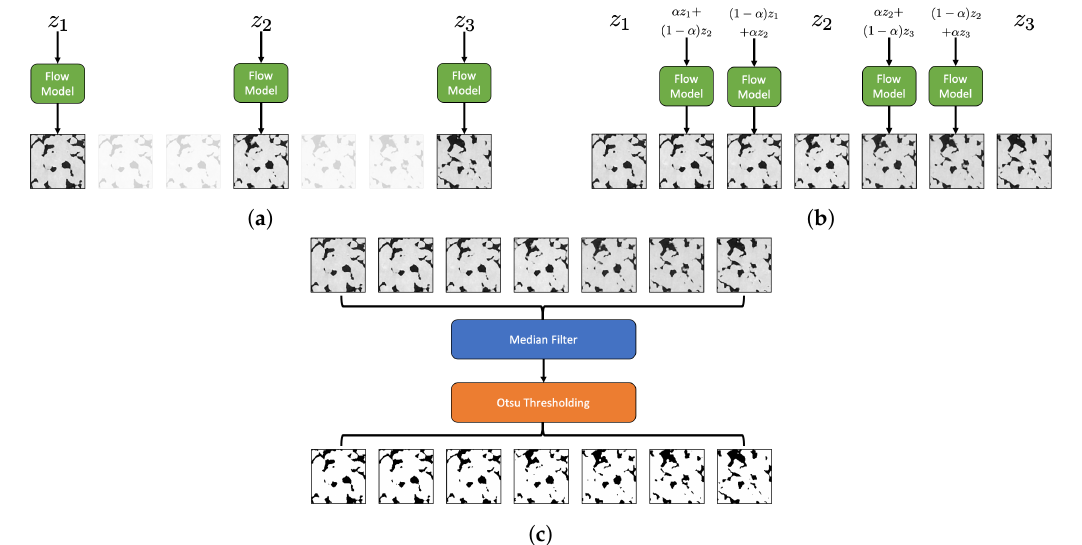
Figure 3. Image volume generation algorithm: ( a ) anchor slices are sampled by choosing random vectors z i according to the prior optimized during model training and then by sampling the corresponding rock image slices. For automatic step number computation, these images are binarized and the pore chord length is computed. ( b ) Linear combinations of the anchor slice latent vectors are computed, and the intermediate image slices are evaluated to create the full image volume. Evaluation of all volume slices can be done in parallel. ( c ) Postprocessing was performed for generated images. Applying a spherical median filter to the generated images improves the resulting output images. Images are optionally segmented using Otsu thresholding to create a final image binary for quantifying spatial statistics or for performing flow simulations. Other segmentation algorithms or software could be used, but we leave this as an area for future